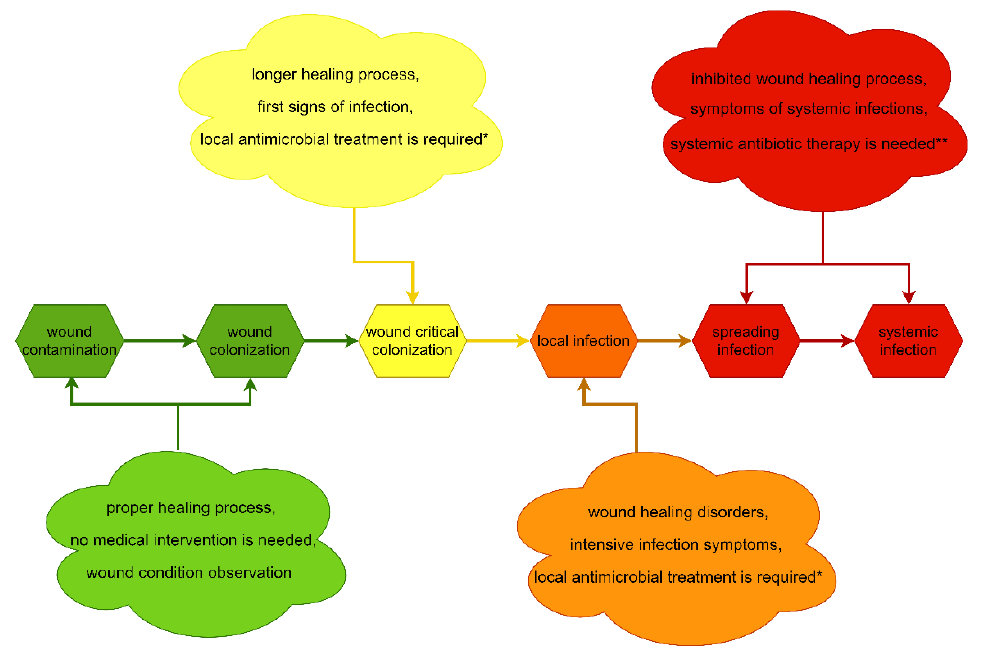
Figure 1. Stages of wound infection and corresponding clinical symptoms [9,10,12]. * antisepsis, wound debridement, antimicrobial dressings, non-antibiotic local treatment. Local antibiotic therapy is not recommended. ** systemic empiric antibiotic therapy depends on the clinical condition of the patient. Empirical treatment should consider the expected pathogens, the site and nature of the infection, and cover the broadest possible spectrum of microorganisms. Empirical antibiotic therapy should be turned into targeted antibiotic therapy as soon as possible after obtaining microbiology test results.